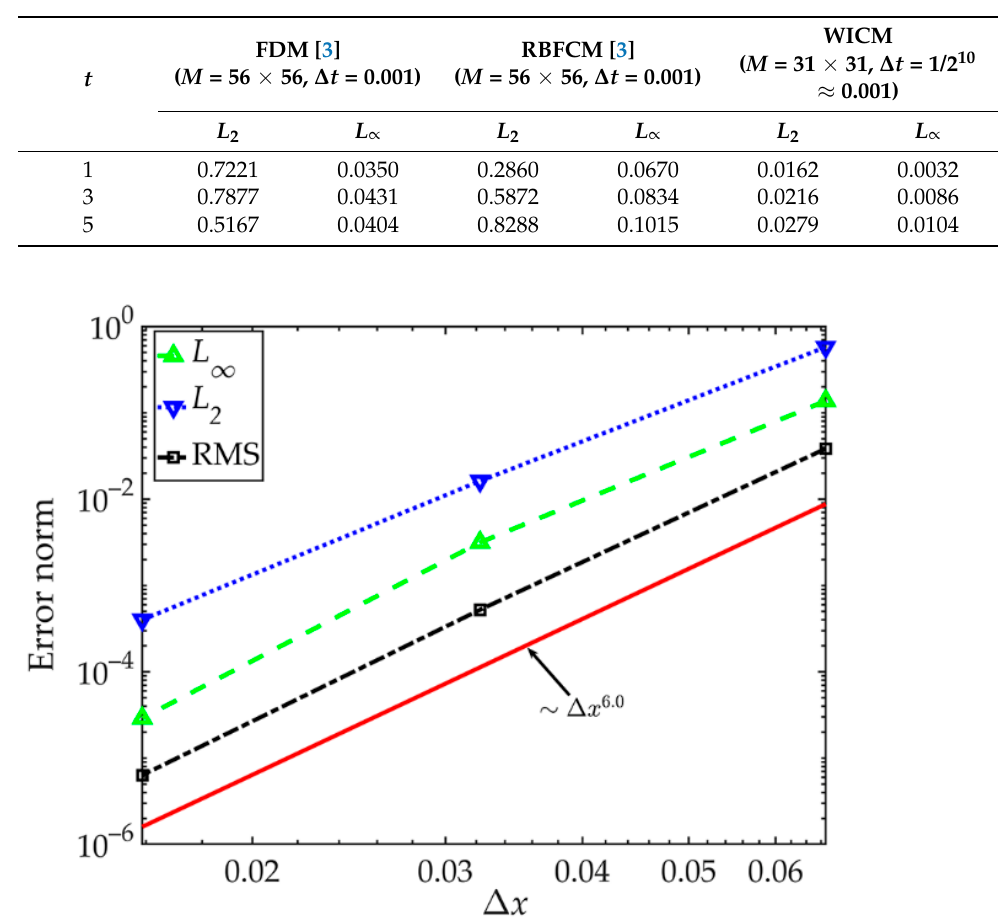
Table 5. Error norms of numerical solutions at different time t for Case I of Example 3.